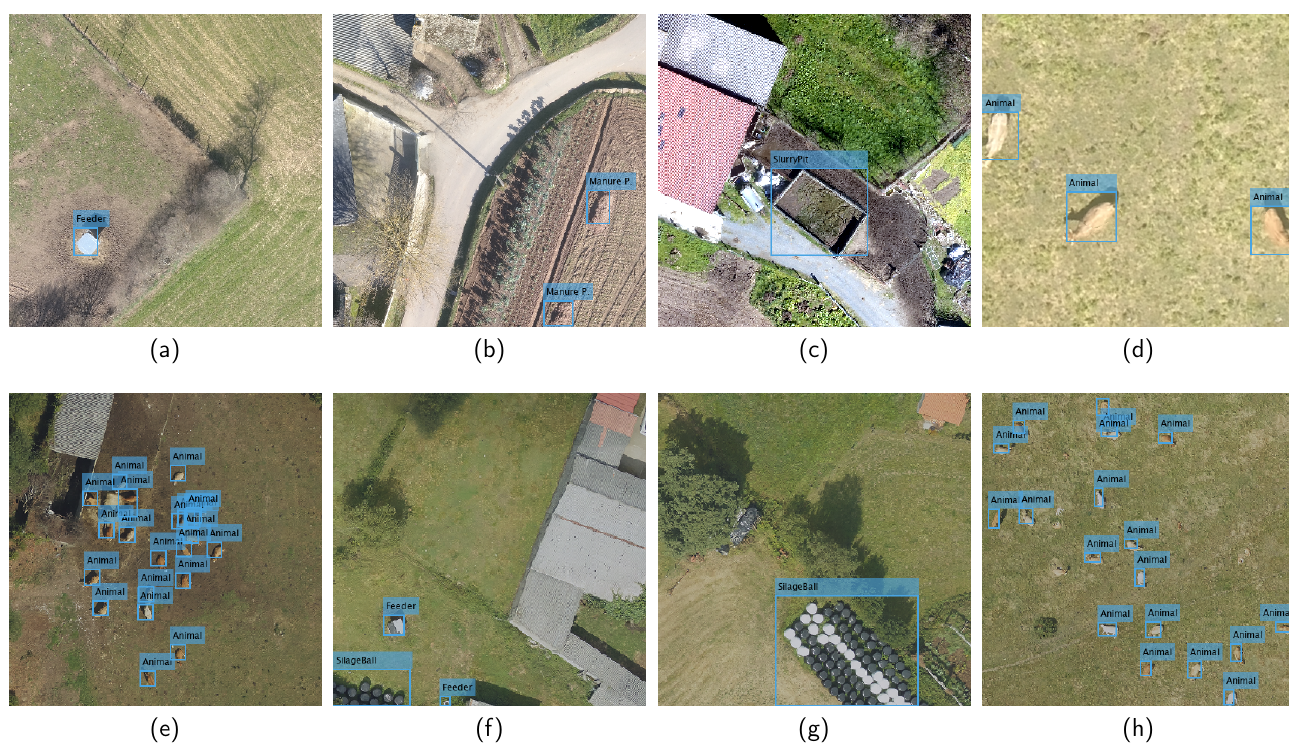
Figure 6. Detection results on some of the test images using YOLOv5. ( a ) one feeder; ( b ) two manure piles; ( c ) one slurry pit; ( d ) three animals; ( e ) twenty-two animals; ( f ) two feeders and one silage ball group; ( g ) one silage ball group; ( h ) eighteen